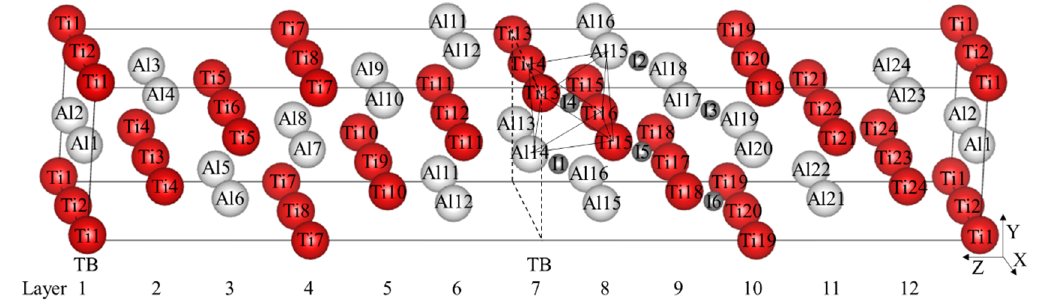
Figure 1. (Color on line) γ -TiAl twin model and 6 octahedral interstitials. The red larger spheres are Ti atoms, the white larger spheres are Al atoms, the gray smaller spheres are octahedral interstitial positions, and the labels in the spheres represent the corresponding atomic numbers or interstitial numbers. I1–I3 represent Al-rich octahedral interstitial positions and I4–I6 represent those that are Ti-rich. The label TB and dotted lines represent twin boundary. Ti13, Ti14, Ti15, Ti16, Al14, and Al15 form an octahedron besieging I4 interstitial site.